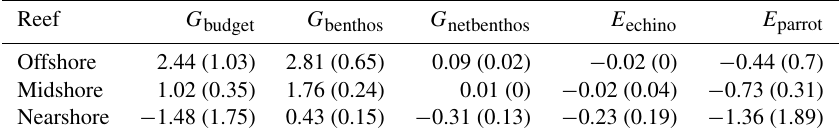
Table 3. Reef carbonate budgets and contributing biotic variables (kg CaCO 3 m − 2 yr − 1 ) along a cross-shelf gradient in the central Red Sea. Calcification rates of benthic calcifiers ( G benthos ), net-accretion/-erosion rates of the reef “rock” surface area ( G netbenthos ), and the erosion rates of echinoids and parrotfish ( E echino , E parrot ) contribute to the total carbonate budget ( G budget ) at a reef site. Shown are means per site and standard deviations (in brackets).